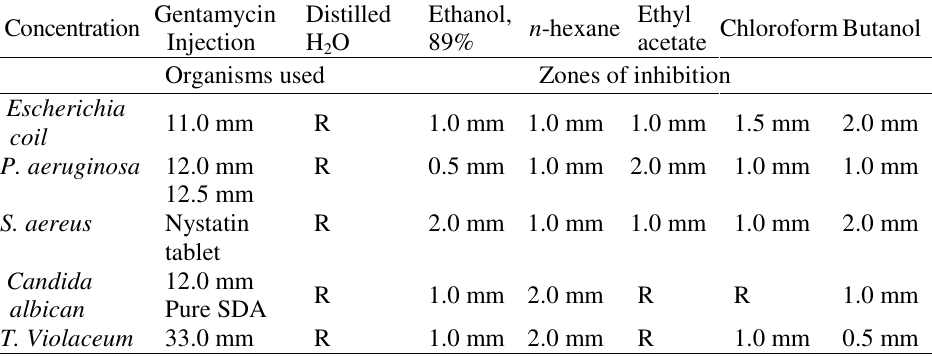
Table 3. Effects of pure solvents, gentamycin injection and nystatin tablet alone on the test microorganism as control on they zones of